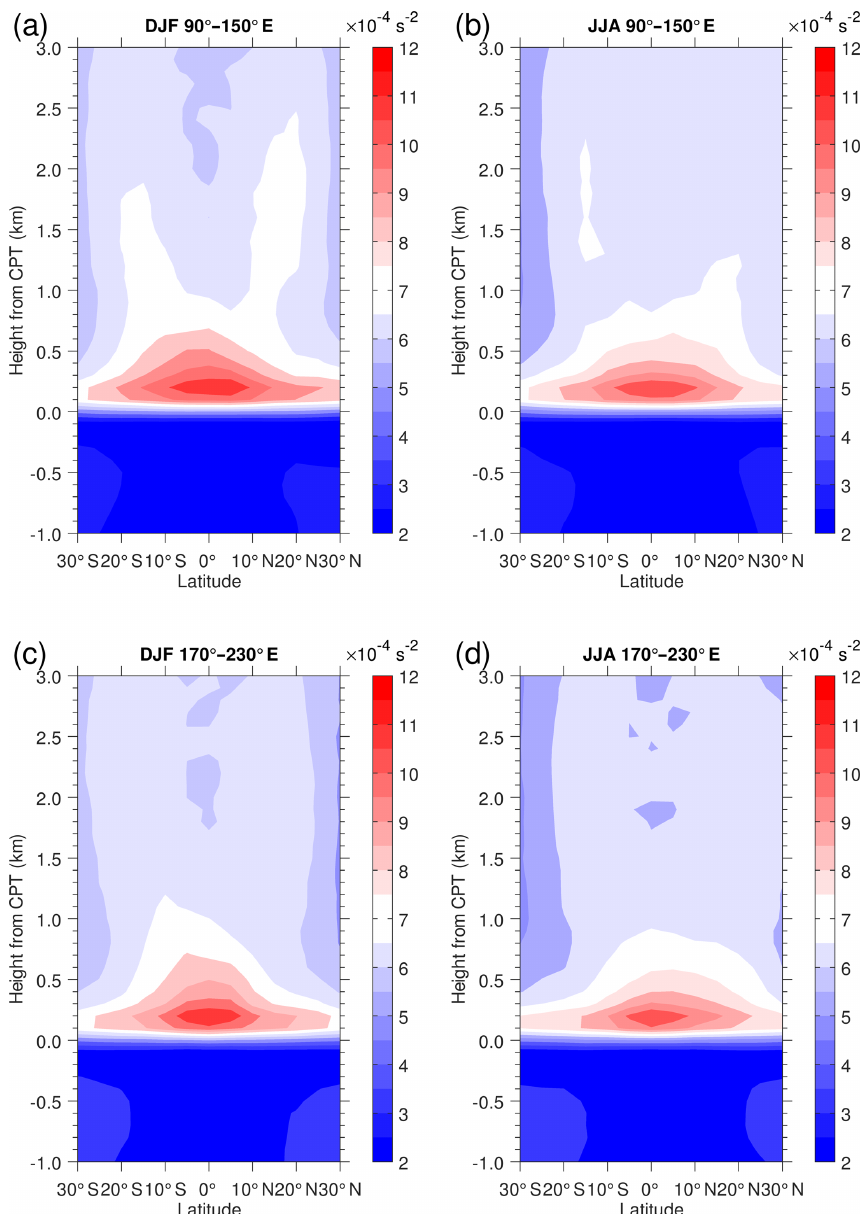
Figure 3. Height–latitude cross sections of the mean N 2 relative to the CPT location in the vertical for (a, c) DJF and (b, d) JJA in the two longitude regions. Color contour interval is 0 . 5 × 10 − 4 s − 2